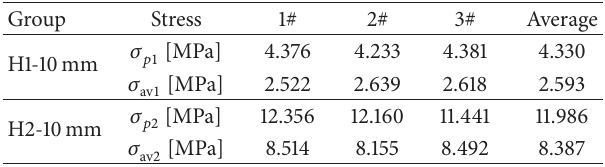
Table 1: Initial peak stress and the crushing stress of